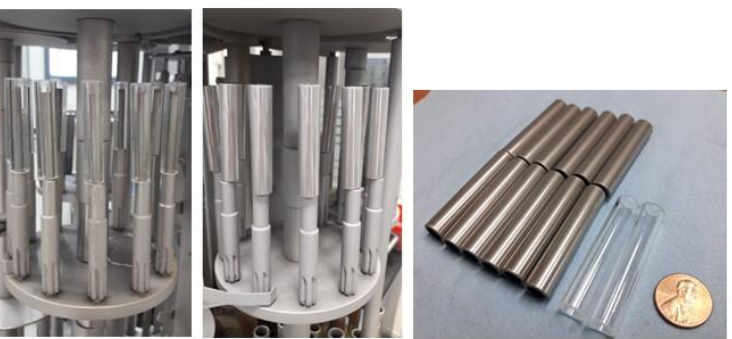
Figure 13. Raching rings prepared for the PVD process ( left ), and substrates after arc-PVD TiO x deposition ( middle and right ). deposition ( middle and right